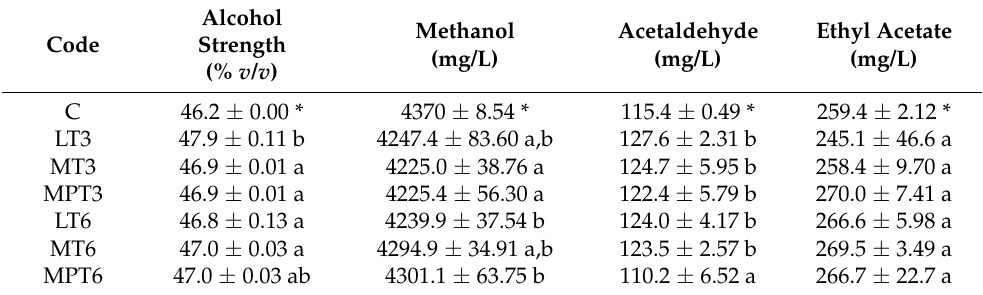
Table 2. Mean and Standard deviation of alcohol strength, methanol, acetaldehyde, and ethyl acetate of the AUS aged with oak